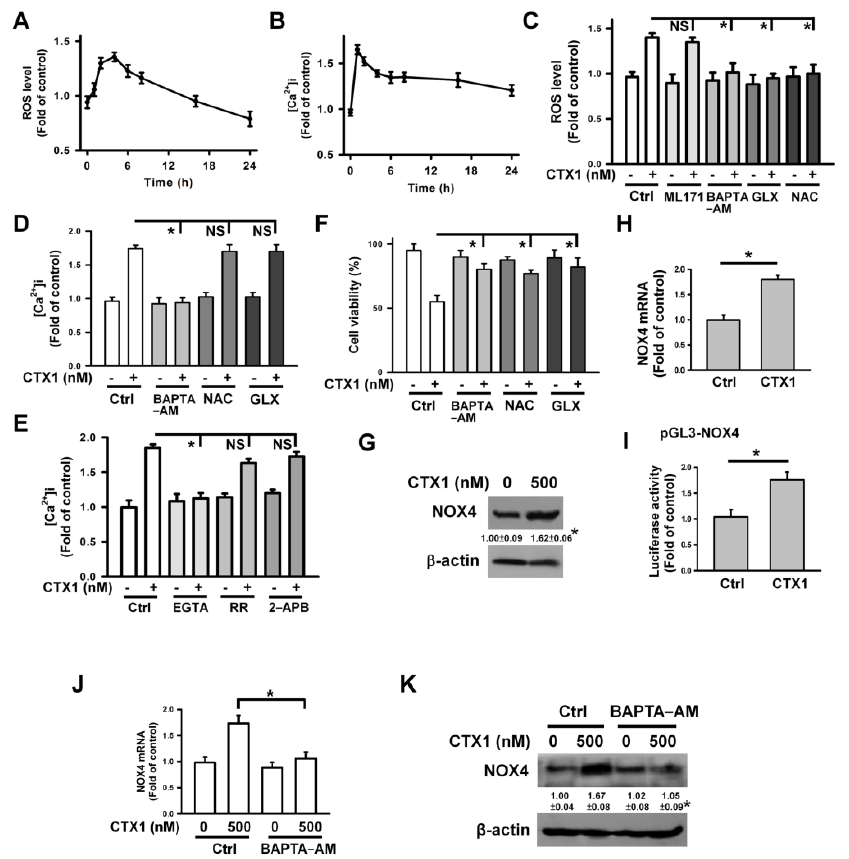
Figure 3. Effect of CTX1 on [Ca 2+ ]i and ROS level in U937 cells. U937 cells were treated with 500 nM CTX1 for 2 h (for measuring [Ca 2+ ]i) or 4 h (for measuring ROS level and cell viabil- ity). On the other hand, U937 cells were pretreated with 2 mM N-acetylcysteine (NAC), 10 µ M BAPTA-AM, 10 µ M GLX351322, 10 µ M ML171, 10 µ M EGTA, 10 µ M ruthenium red (RR), or 50 µ M 2-aminoethoxydiphenyl borane (2-APB) for 1 h and then incubated with 500 nM CTX1 for 2 h (for measuring [Ca 2+ ]i) or for 4 h (for measuring ROS level and cell viability). ( A ) CTX1 induced ROS generation in U937 cells. U937 cells were treated with 500 nM CTX1 for indicated time periods. Results were shown as fold-increase in fluorescence intensity compared with the control group. Each value is the mean ± SD of three independent experiments with triplicate measurements. ( B ) CTX1 induced an elevation of [Ca 2+ ]i in U937 cells. U937 cells were treated with 500 nM CTX1 for indicated time periods. Results were shown as fold-increase in fluorescence intensity compared with the control group. ( C ) Effect of BAPTA − AM, NAC, ML171, and GLX351322 on CTX1-induced ROS generation (mean ± SD, * p < 0.05; NS, not statistically significant). ( D ) Effect of BAPTA − AM, NAC, and GLX351322 on CTX1-induced an increase in [Ca 2+ ]i (mean ± SD, * p < 0.05; NS, not